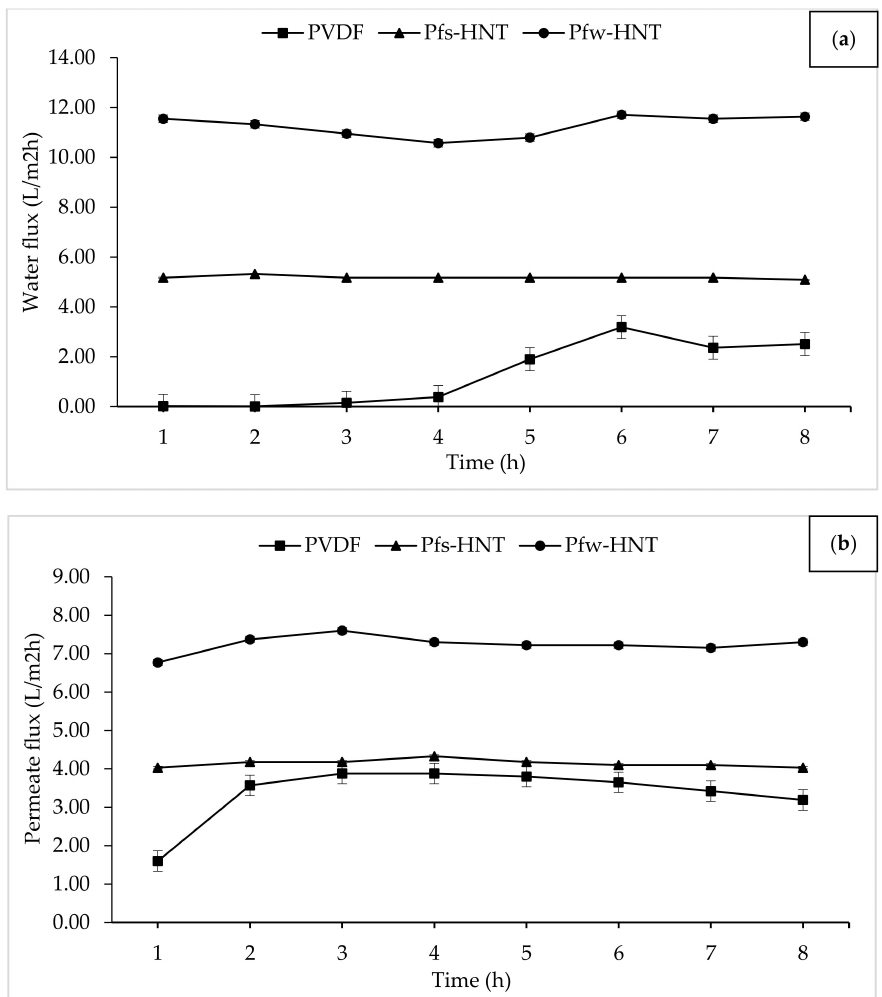
Figure 7. Evaluation of membrane permeability using water and aquaculture seawater. The prepared membranes were exposed to 16 h of MD process; ( a ) 8 h water vapor permeation by water and ( b ) 8 h of water vapor permeation from aquaculture seawater as